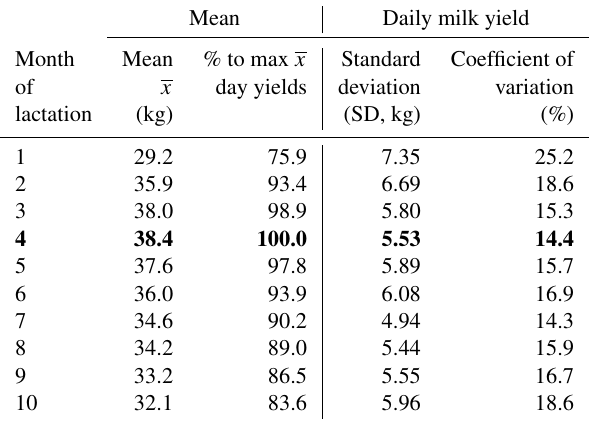
Figure 4. Feeding table.